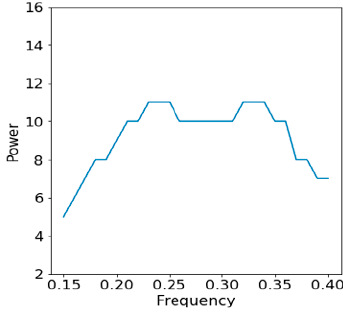
Figure 2. Motivating example 2 in which it is difficult to find a single DRF, because there are two peak points at 0.24 Hz and 0.33 Hz with almost the same power.